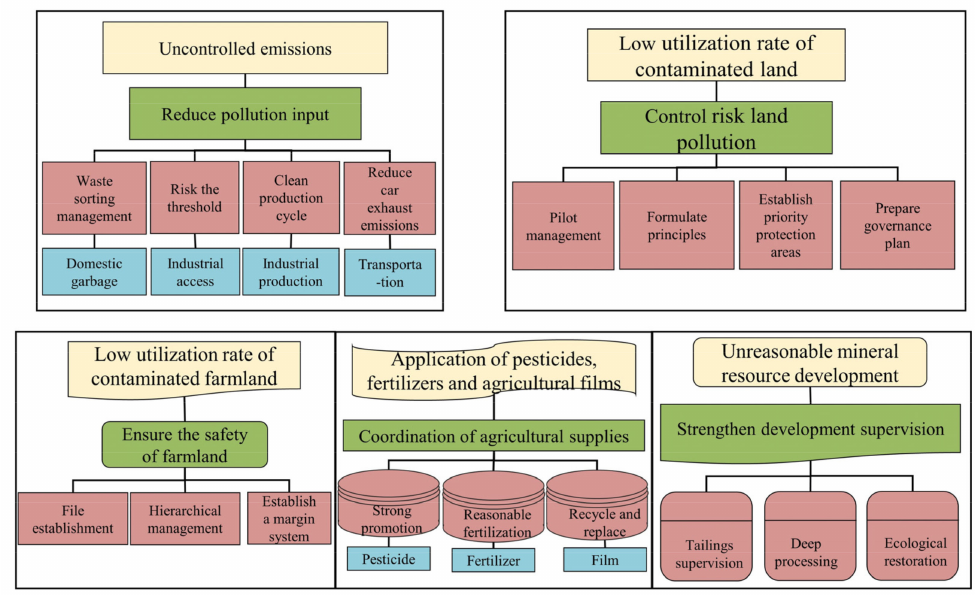
Figure 5. The main contents of the countermeasures of the “soil safety” of the Pearl River